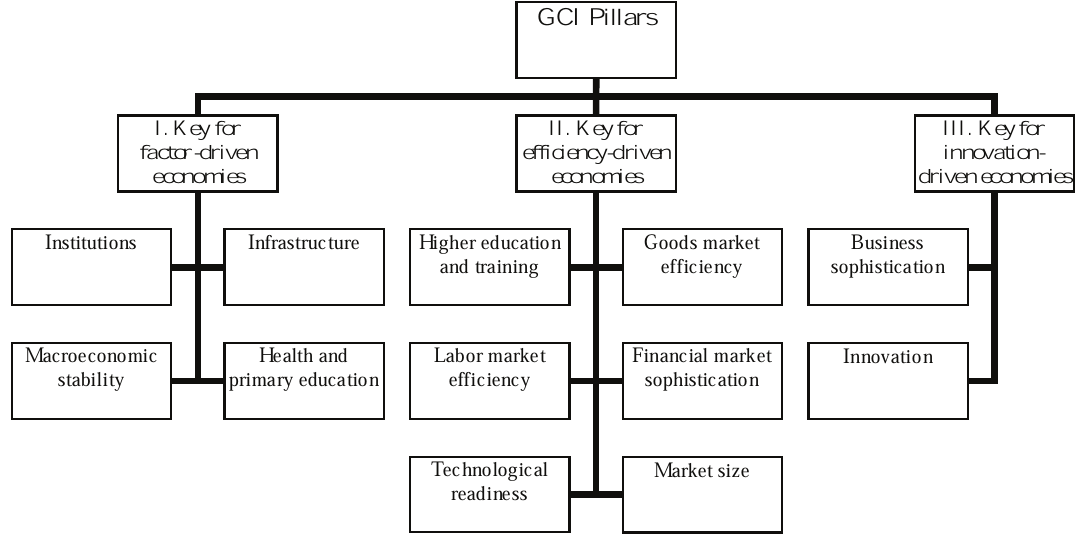
Fig. 5. The 12 pillars of competitiveness (Schwab